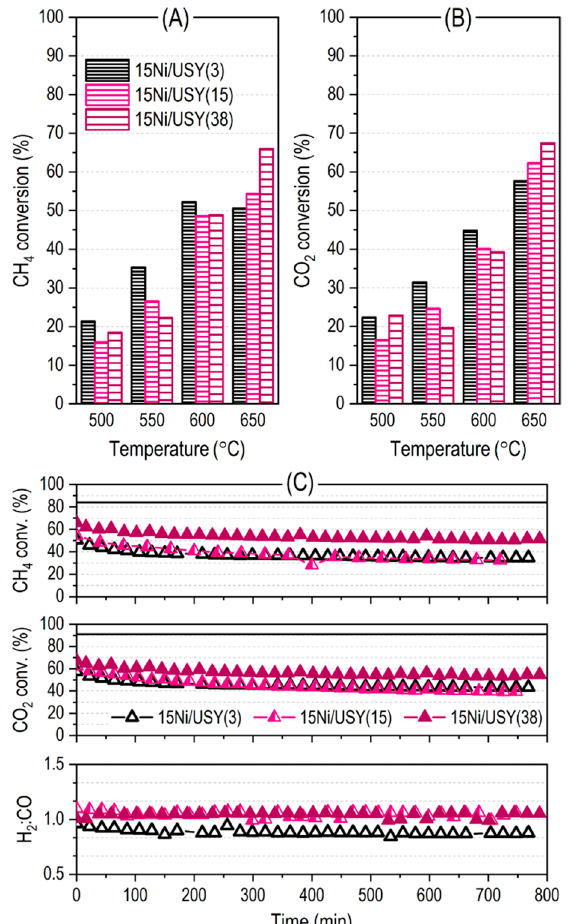
Figure 7. Variation of ( A ) CH 4 and ( B ) CO 2 conversion levels as a function of temperature (500–650 °C) and ( C ) CH 4 conversion, CO 2 conversion and H 2 :CO molar ratio as a function of time on stream (T= 650 °C) during DRM (P = 1 atm, CH 4 :CO 2 = 1:1, GHSV = 72 L g − 1 h − 1 ) over 15Ni/USY(3), 15Ni/USY(15) and 15Ni/USY(38) catalysts. Thermodynamic values of CH 4 , CO 2, and H 2 :CO (straight black line) in ( C ) were calculated using the HSC 7.1 software.